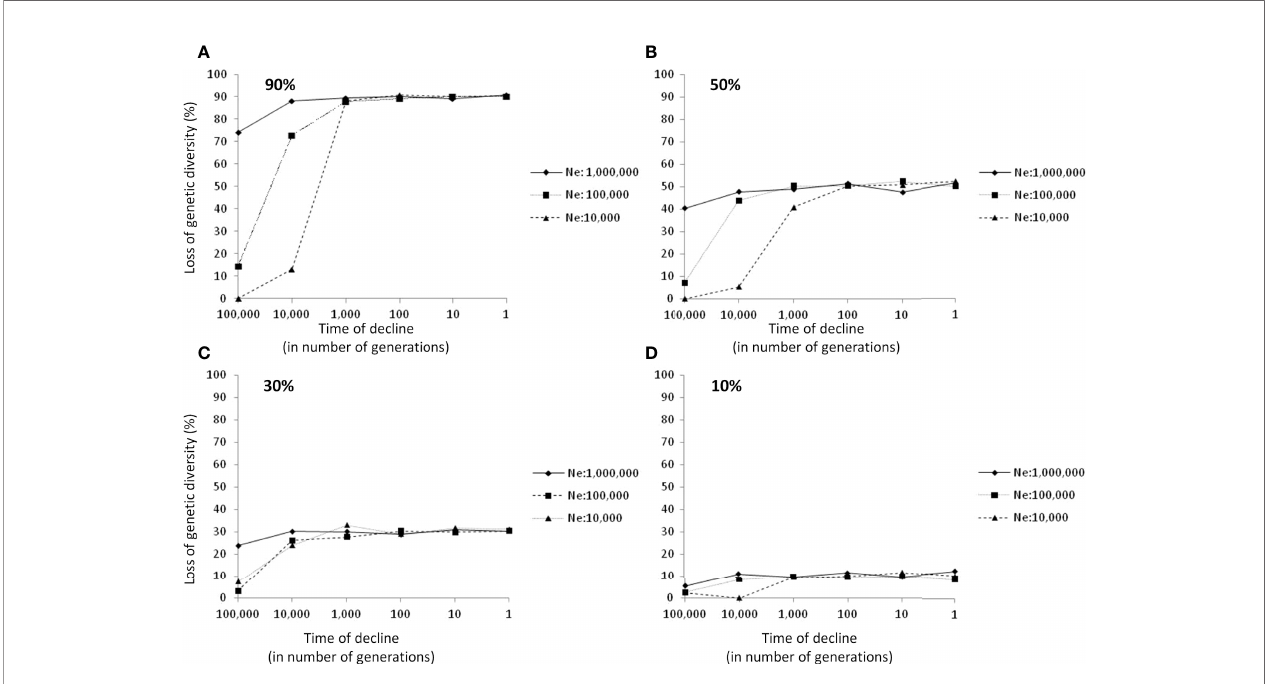
FIGURE 2 | Average genetic diversity loss expected by declines in population census of 90% (A) , 50% (B) , 30% (C) , and 10% (D) of its original size. Each mark represents the average loss of genetic diversity expected from 1000 random-generated samples that experienced a decline in population census at a different time (100,000; 10,000; 1,000; 100; 10; or 1 generations ago). Three different effective population sizes were simulated (Ne=10e 6 , 10e 5 and 10e 4 ) for each time of decline and each percentage of decline (N=72 simulations in total). The starting value of Ɵ was 2.5, which is an approximation to the median value of worldwide and East Asia fi sh datasets ( Supplementary Table S2